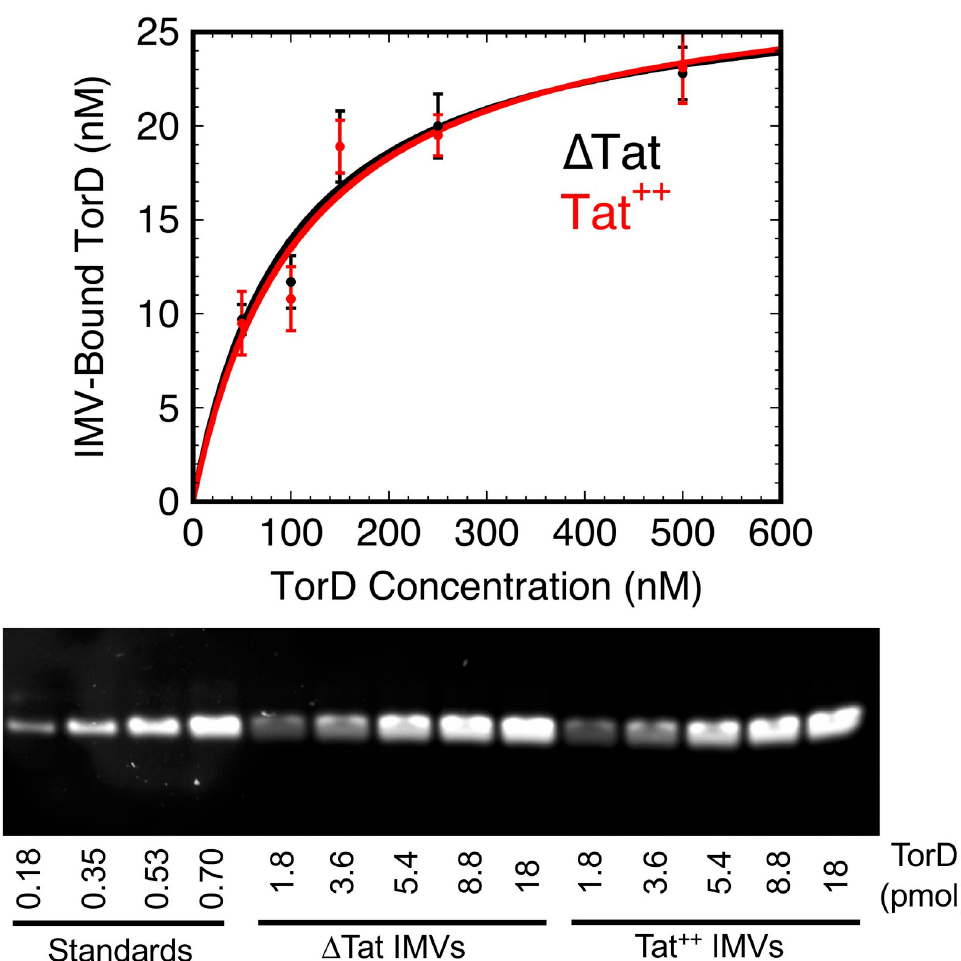
Fig 8. TorD has similar affinities for Δ Tat and Tat ++ IMVs. Different concentrations of TorD(Alexa532) were incubated with Δ Tat and Tat ++ IMVs ( A 280 = 5; 10 min at 37˚C). IMV pellets were recovered and analyzed for the amount of bound TorD using the approach described for Fig 7. Data were fit using a single site Langmuir binding isotherm model [46], yielding K D values of 100 ± 33 nM and 112 ± 43 nM as well as [TorD] bound(max) values of 28 ± 3 nM and 29 ± 4 nM for Δ Tat and Tat ++ IMVs,